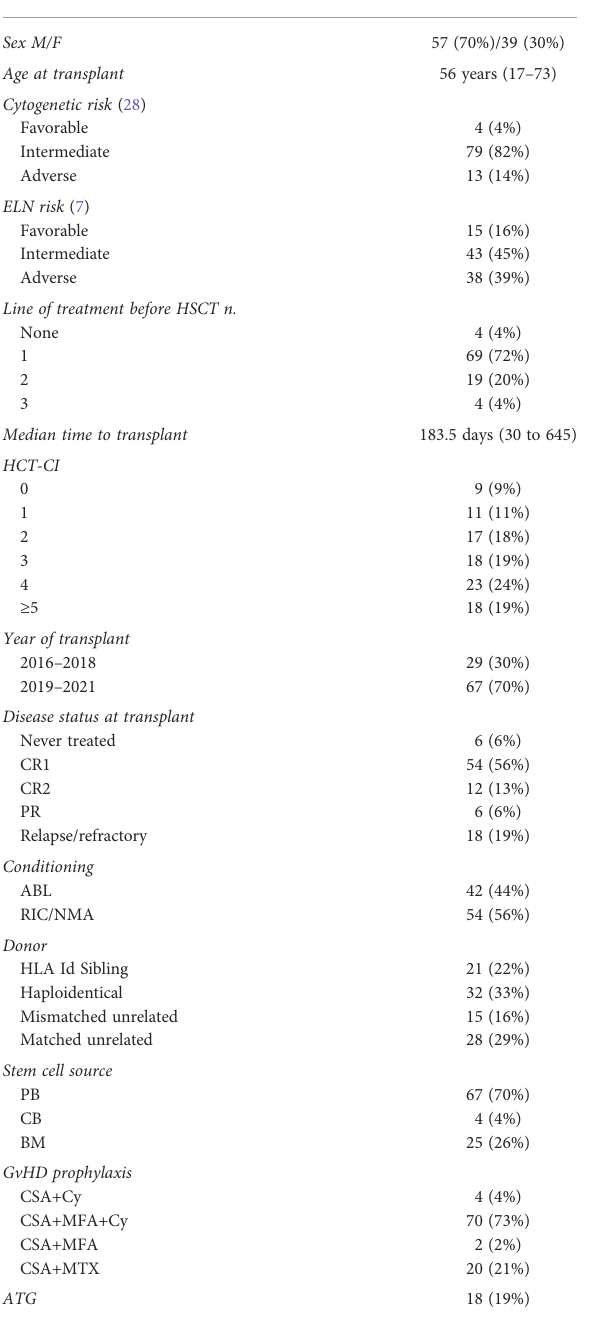
TABLE 2 Patients, disease, and transplant